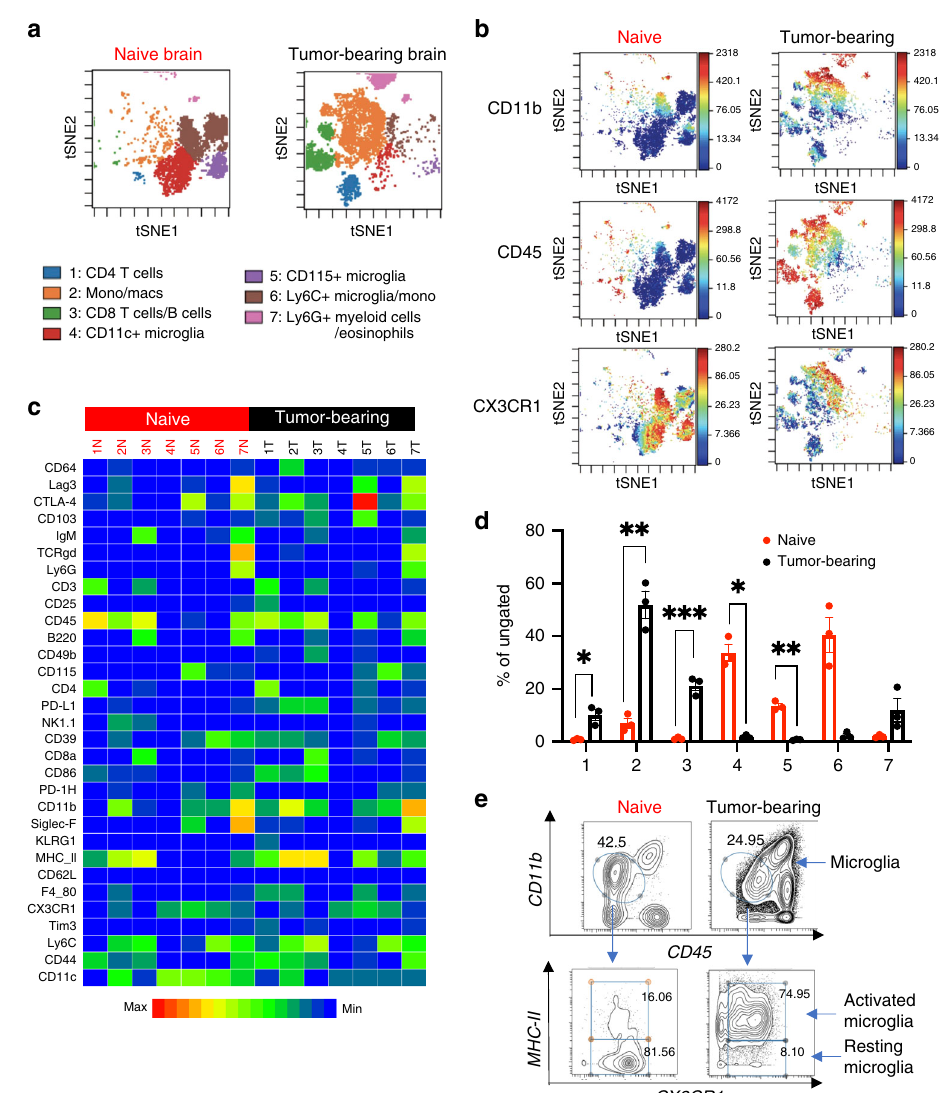
Fig. 2 Tumor-bearing brain shows distinct population of in fi ltrating immune cells. a Concatenated FlowSOM analysis of naïve brain vs. tumor-bearing brain showing seven metaclusters (representative plot from two independent experiments with n = 3 mice/group). b Expression of CD11b, CD45 and CX3CR1 in viSNE clusters of naïve vs. tumor-bearing brain. c Heatmap showing expression pro fi le of metaclusters in concatenated samples. d Percent population in each metacluster of naïve vs. tumor-bearing brain. Data represented as average ± SE for n = 3 mice/group. Data representative of two independent experiments. Two-sided Student ’ s t test with Holm – Sidak corrections for multiple comparisons was applied. * p ≤ 0.05; ** p ≤ 0.005; *** p ≤ 0.0007. e Representative fl ow plot of resting and activated microglia in naïve vs. tumor-bearing brain. Microglia was gated as CD11b low/CD45 low which was further gated for MHC-II high/CX3CR1 high (activated microglia) and MHC-II low/CX3CR1 high (resting